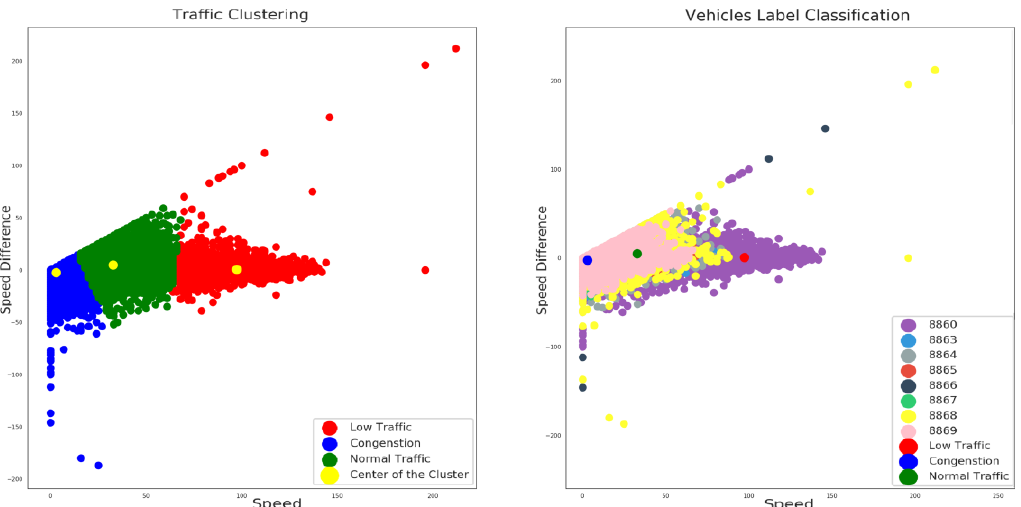
16 of 22 Figure 6. Elbow method result for clustering purposes of batch data of fleet 2. The choice of the K-means algorithm for clustering based on feature similarity was performed because it is one of the most widely used machine learning methods for unsu- pervised learning. More specifically, K-means aims to determine the number of similar object or behaviour groups that are more related to each other than to objects of other groups from a dataset of unlabeled input data. The K-means algorithm is commonly indi- cated as a prototype-based clustering algorithm, where each cluster is depicted by a pro- totype, which can be either the average of similar points (centroids) or the most frequently occurring points (medoid). In our case, the representation of each cluster is denoted by the Euclidean distances between the centroids and the existing vehicles’ data points. The squared Euclidean distance is a widespread method approach for calculating the similar- ity instead of the distance between the data objects and is calculated based on Equation (1) [43]: